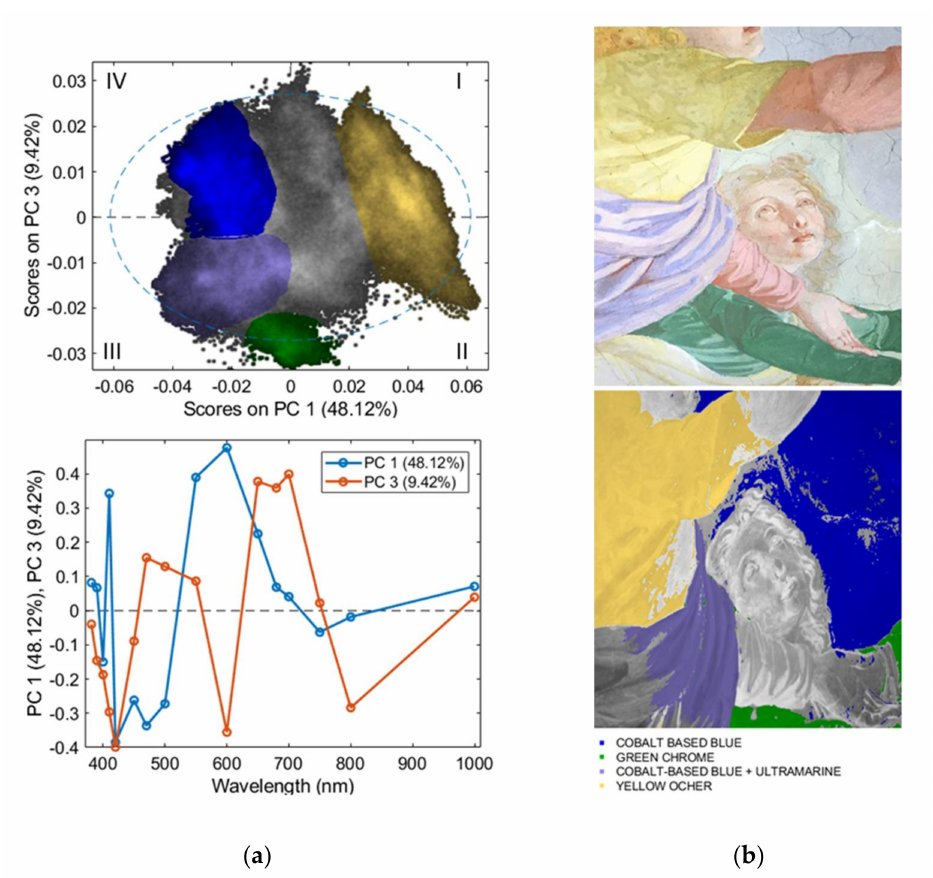
Figure 8. PCA score and loading plot of PC1 and PC3 ( a ) and relative false color image of AREA 1 ( b